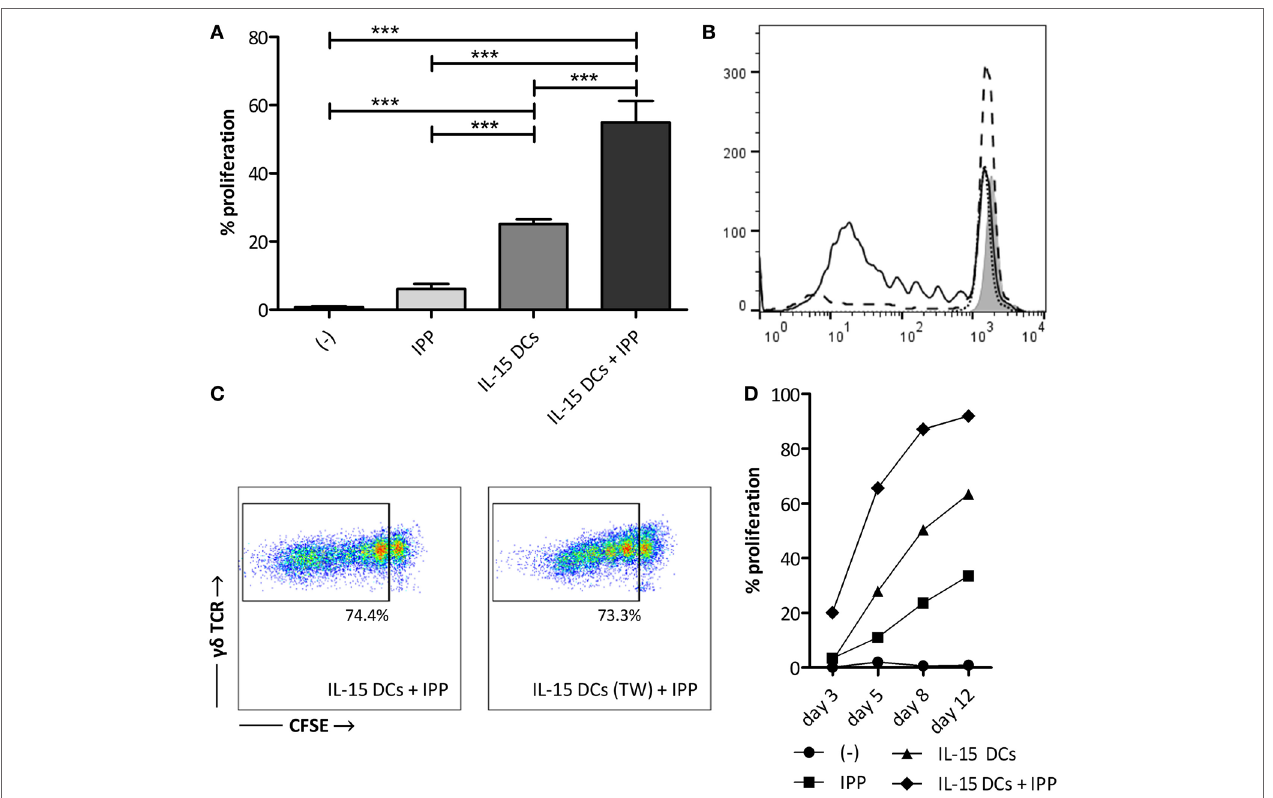
FigUre 1 | IL-15 dendritic cells (DCs) induce γδ T cell proliferation in a contact-independent manner. (a) γδ T cells in full peripheral blood mononuclear cell (PBMC) fraction were stimulated with isopentenyl pyrophosphate (IPP), IL-15 DCs (E:T ratio = 1:10) or IL-15 DCs + IPP for 5 days. Unstimulated PBMCs ( − ) were used as negative control. γδ T cell proliferation, as assessed by reduction in CFSE staining, was determined by flow cytometry. The percentage of cells to have undergone at least one cell division is shown ( n = 12). One-way ANOVA with Bonferroni’s Multiple Comparison Test. (B) The histogram overlay shows CFSE dilution of viable γδ T cells within unstimulated PBMCs (filled gray), PBMCs stimulated with IPP (dotted line), IL-15 DCs (dashed line), and IL–15 DCs + IPP (full line) for one representative donor. (c) Dot plots of one representative donor ( n = 3) showing the CFSE-dilution of proliferated γδ T cells in PBMCs stimulated with IL-15 DCs + IPP with and without IL-15 DCs in transwell (TW). (D) γδ T cell proliferation over time (experimental setup in line with panel A; n = 3). *** p <